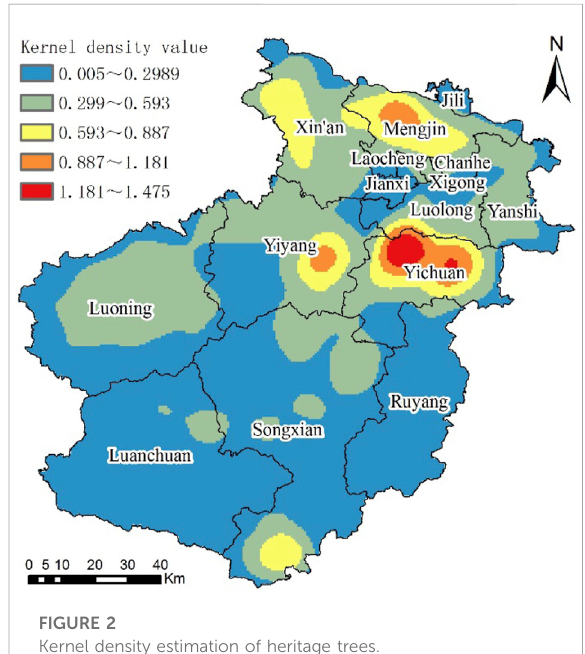
FIGURE 2 Kernel density estimation of heritage